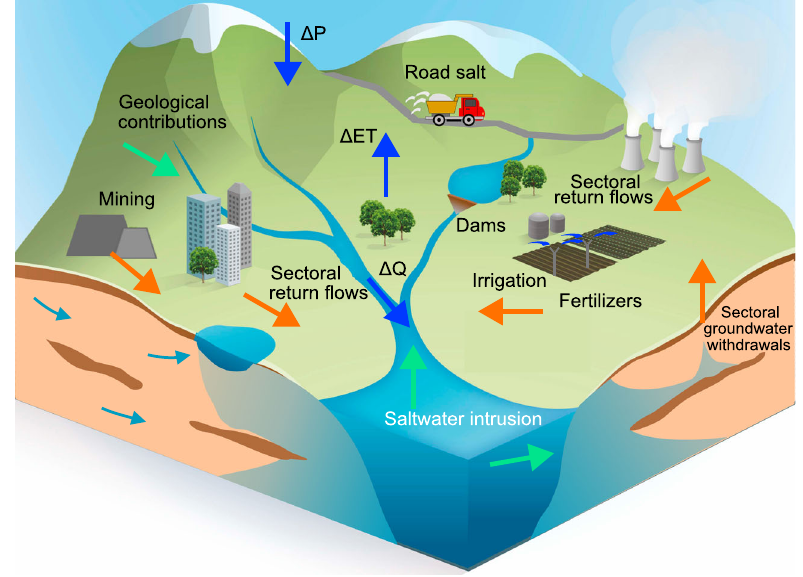
Fig. 1 Potential drivers of freshwater salinisation within a hydro(geo)logical landscape. The drivers are categorised according to hydroclimatic (blue arrows), geographic (green arrows) and human (orange arrows) drivers. Examples of human drivers include polluted return fl ows from agricultural, domestic, and industrial activities (including mining), as well as road salt applications and saltwater intrusion caused by excessive groundwater withdrawals. Geographic drivers for instance include geological weathering products, atmospheric salt deposition and natural saltwater intrusion through seawater inundation caused by fresh-saline water density difference effects, tides, storm-surges and even long-term transgressions. Hydroclimatic drivers may impact salinisation through changes in discharge ( Δ Q) and resulting dilution capacity, as well as through increasing evapo-concentration under increasing evapotranspiration ( Δ ET) and/or decreasing precipitation ( Δ P) or discharge ( Δ